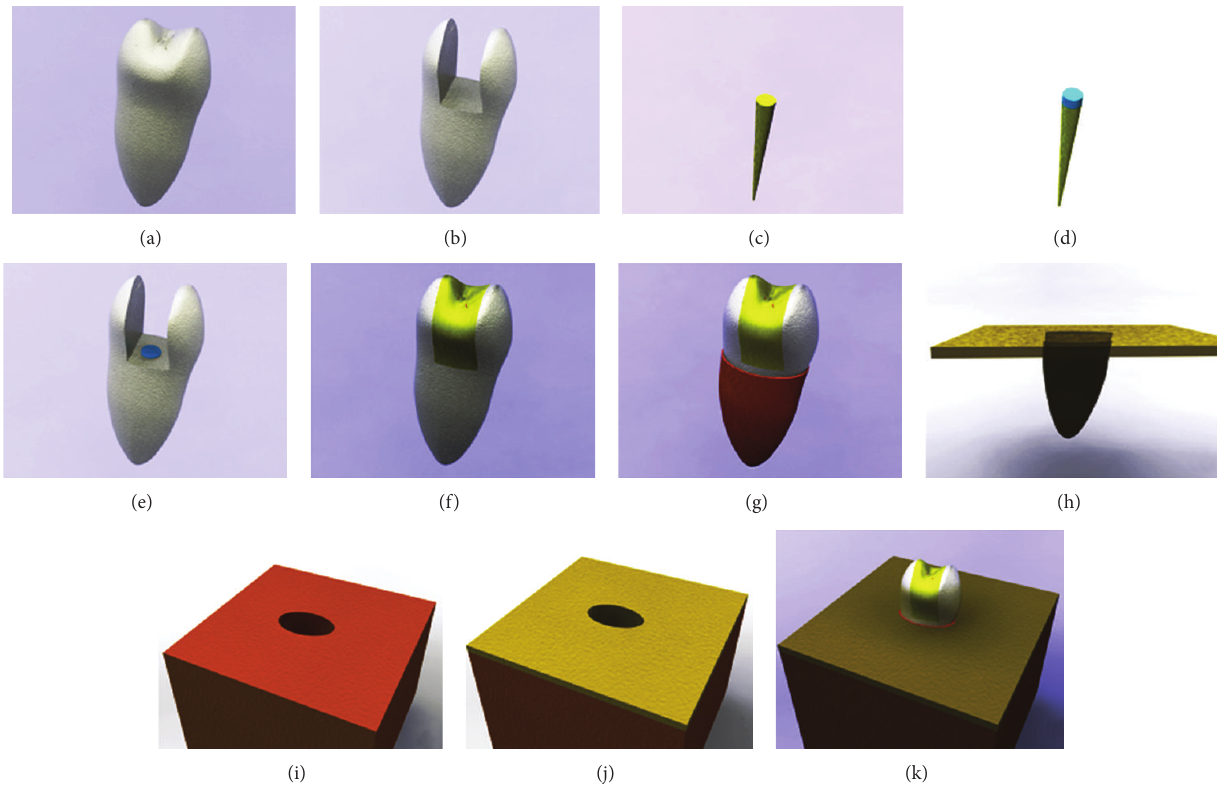
Figure 1: Model preparation, (a) sound tooth model, (b) MOD and endodontic access cavity, (c, d) root-canal filling and resin modified glass ionomer, (e) adaptation of root-canal filling to model, (f) restoration, (g) modeling of PDL, (h, i, j) lamina dura, cortical, and cancellous bone, and (k) model of the endodontically treated